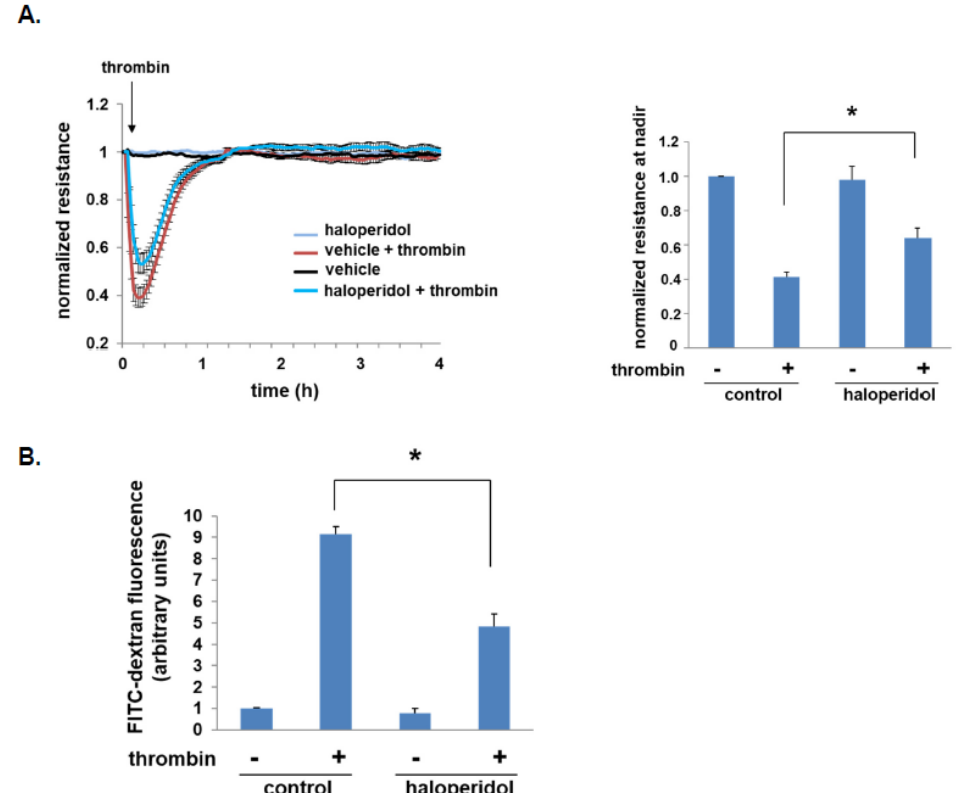
Figure 2. Haloperidol augments EC barrier function. ( A ) Human pulmonary artery ECs were grown to confluence overlying gold-plated microelectrodes for measurements of transendothelial electrical resistance. Cells were pretreated with haloperidol (10 µ M) for 24 h prior to thrombin stimulation (1 U/mL). Real-time measurements of normalized resistance were recorded (left panel), and the nadir for each condition was used for the bar graph (right panel; n = 3/condition, * p < 0.05). ( B ) In separate experiments, human pulmonary artery ECs were grown to confluence in Transwell inserts. Cell monolayers were then treated with haloperidol (10 µ M) for 24 h prior to the simultaneous administration of FITC-dextran (2000 kDa) to the media in each insert and treatment with thrombin (1 U/mL). After 1 h, the media underneath each insert was collected and fluorescence measured ( n = 3/condition, * p <